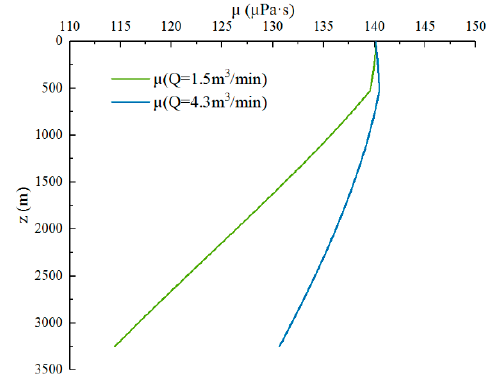
Figure 10. Viscosity profile in the wellbore.